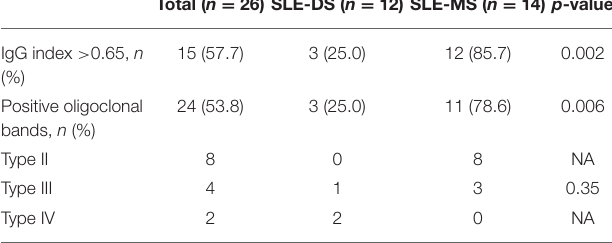
TABLE 2 | Cerebrospinal fluid findings of patients with SLE-demyelinating syndromes compared to SLE-MS.